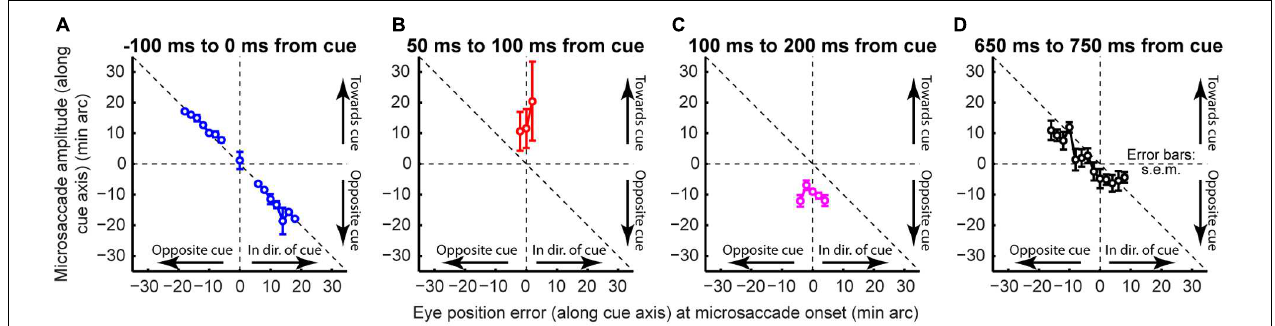
FIGURE 11 | Rocking the boat of fixation. Microsaccade direction as a function of instantaneous eye position error at the time of microsaccade onset. (A) During steady fixation, microsaccades were corrective. (B) Immediately after cue onset, microsaccades were larger than position error (Hafed and Ignashchenkova, 2013). This contributed to getting subsequent movements opposite the cue to correct for the overshoot (C) . By a long time after cue onset (D) , eye movements were corrective once again. The oculomotor system acted like an underdamped control system in the face of cue onset. Error bars denote